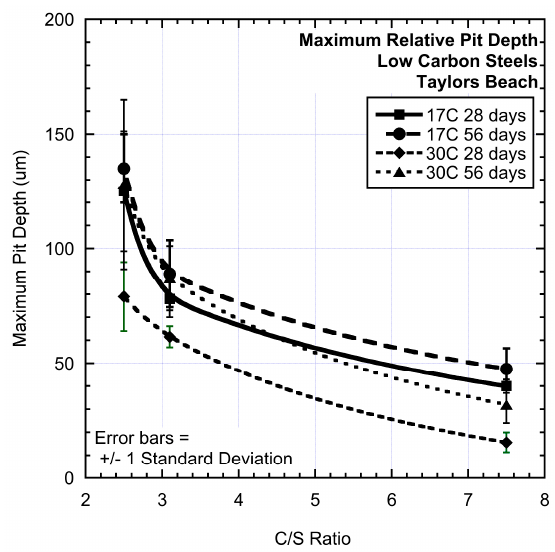
Figure 4. Maximum relative pit depth as a function of the ratio C/S of carbon content/sulphur content, showing ± (one standard deviation) error bars. The standard deviations shown are indicative and are those obtained for the 6 deepest pit depth measurements, as shown in Table 2.